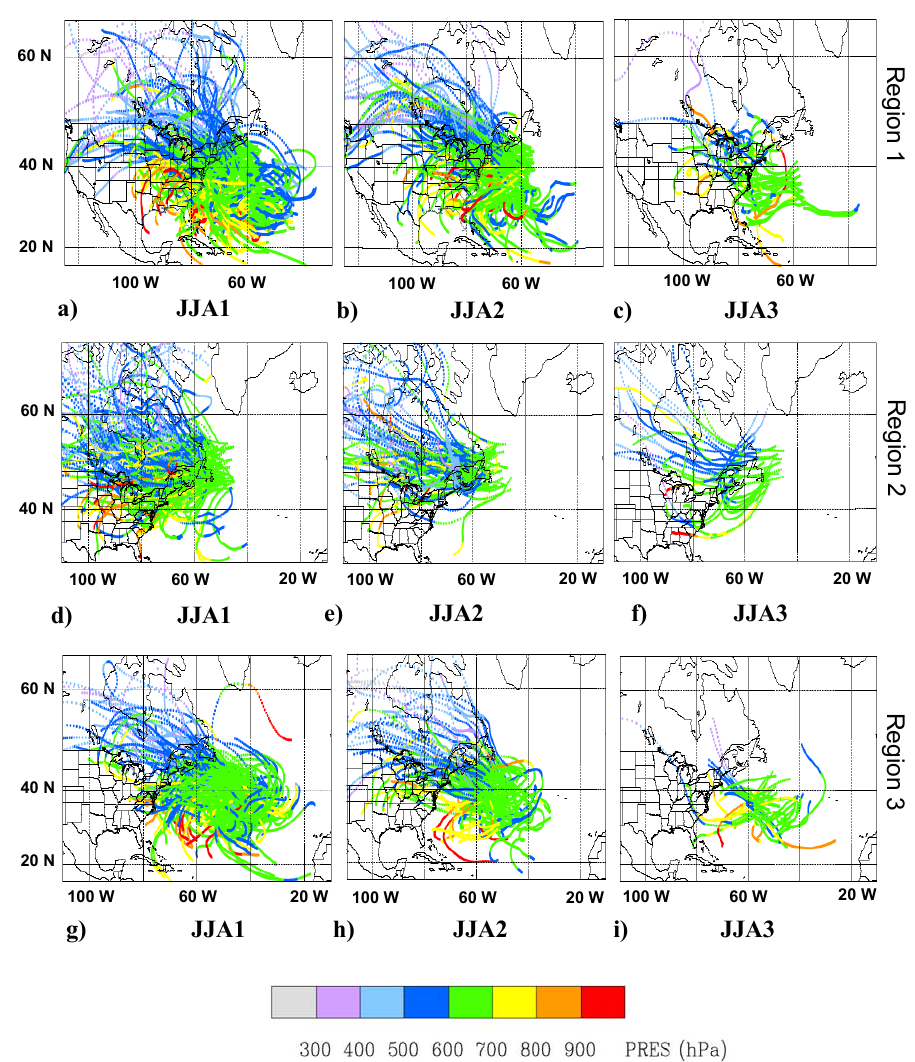
Fig. 13. Four-day HYSPLIT back trajectories using GDAS 1 ◦ × 1 ◦ data from locations of TES 681hPa observations in for map types JJA1-JJA3 in Region 1 (a–c) , Region 2 (d–f) and Region 3 (g–i) . The colors indicate the altitudes of the trajectories in pressure